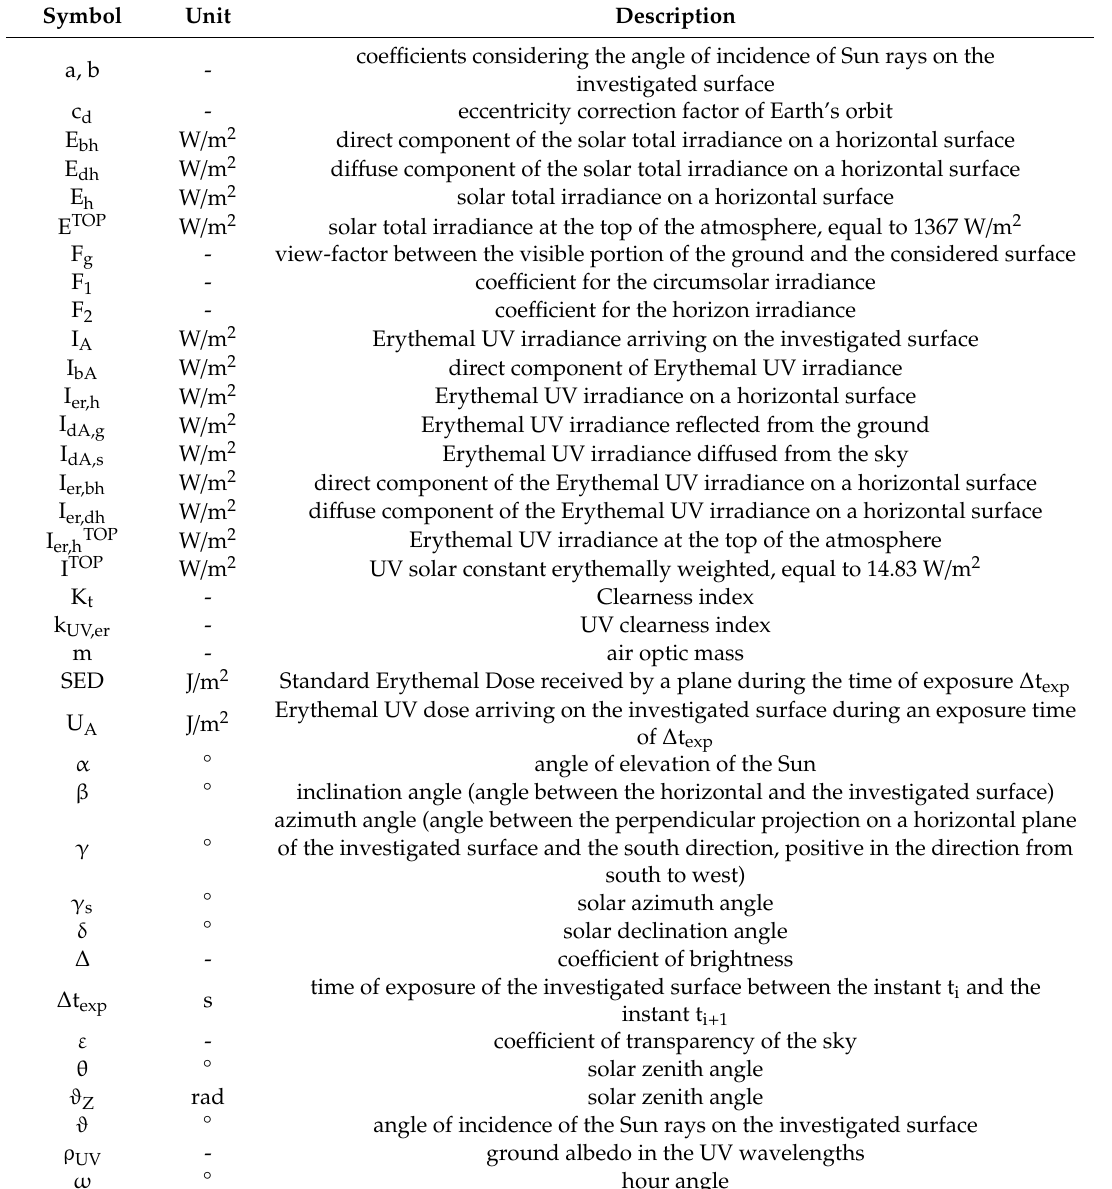
Table A2. List of used